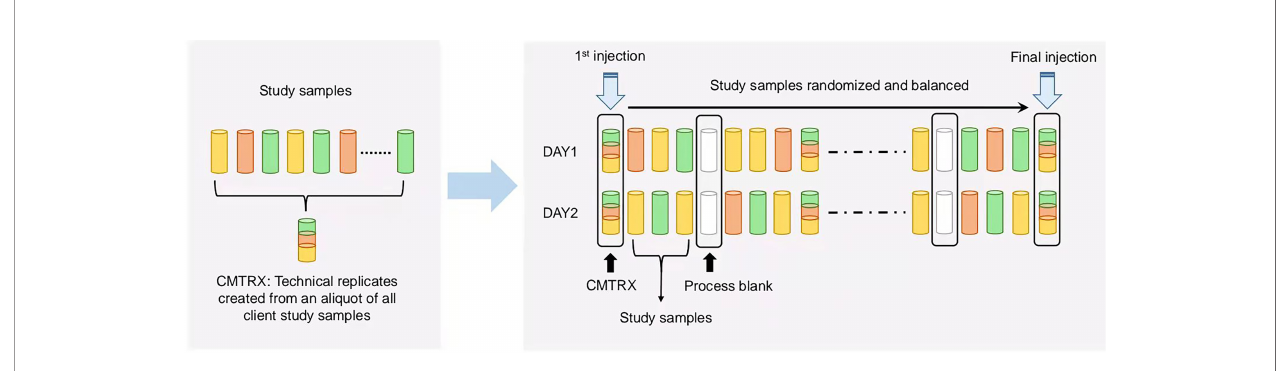
FIGURE 1 | Technical fl owchart of sample preparation for mass spectrometry analysis. A small aliquot of each study sample (colored cylinders) was pooled to create a replicate sample (multicolored cylinder), which was then injected periodically throughout the process. For studies spanning multiple days, a data normalization step was performed to correct variation resulting from instrument inter-day tuning differences. Variability among consistently detected biochemical was used to calculate an estimate of overall process